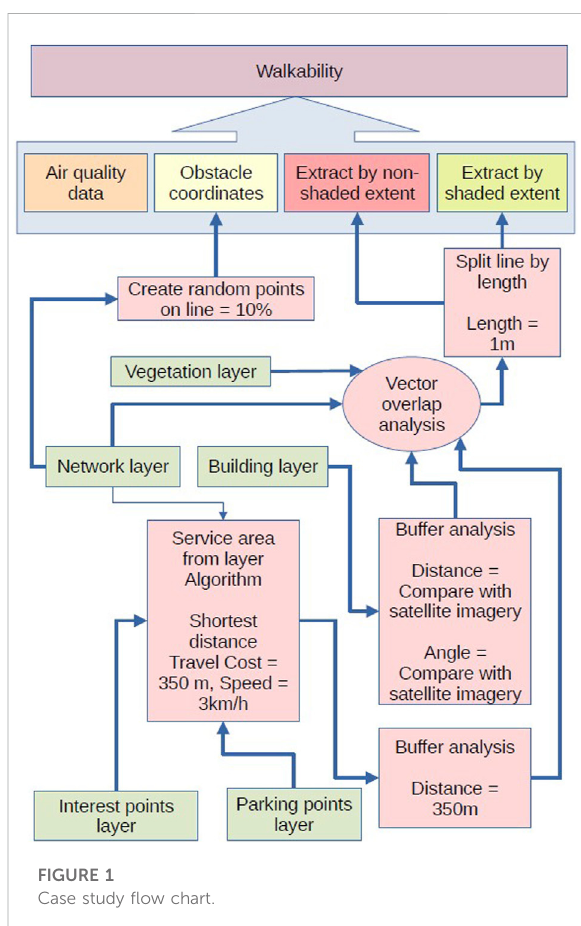
FIGURE 1 Case study fl ow